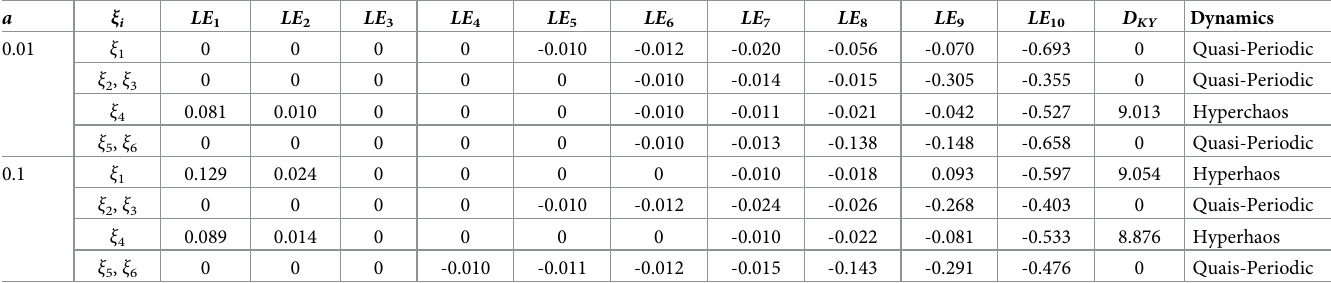
Table 6. Lyapunov exponents, Kaplan-Yorke dimensin and dynamics of system (1) coexisisting attractors with parameter a varying.